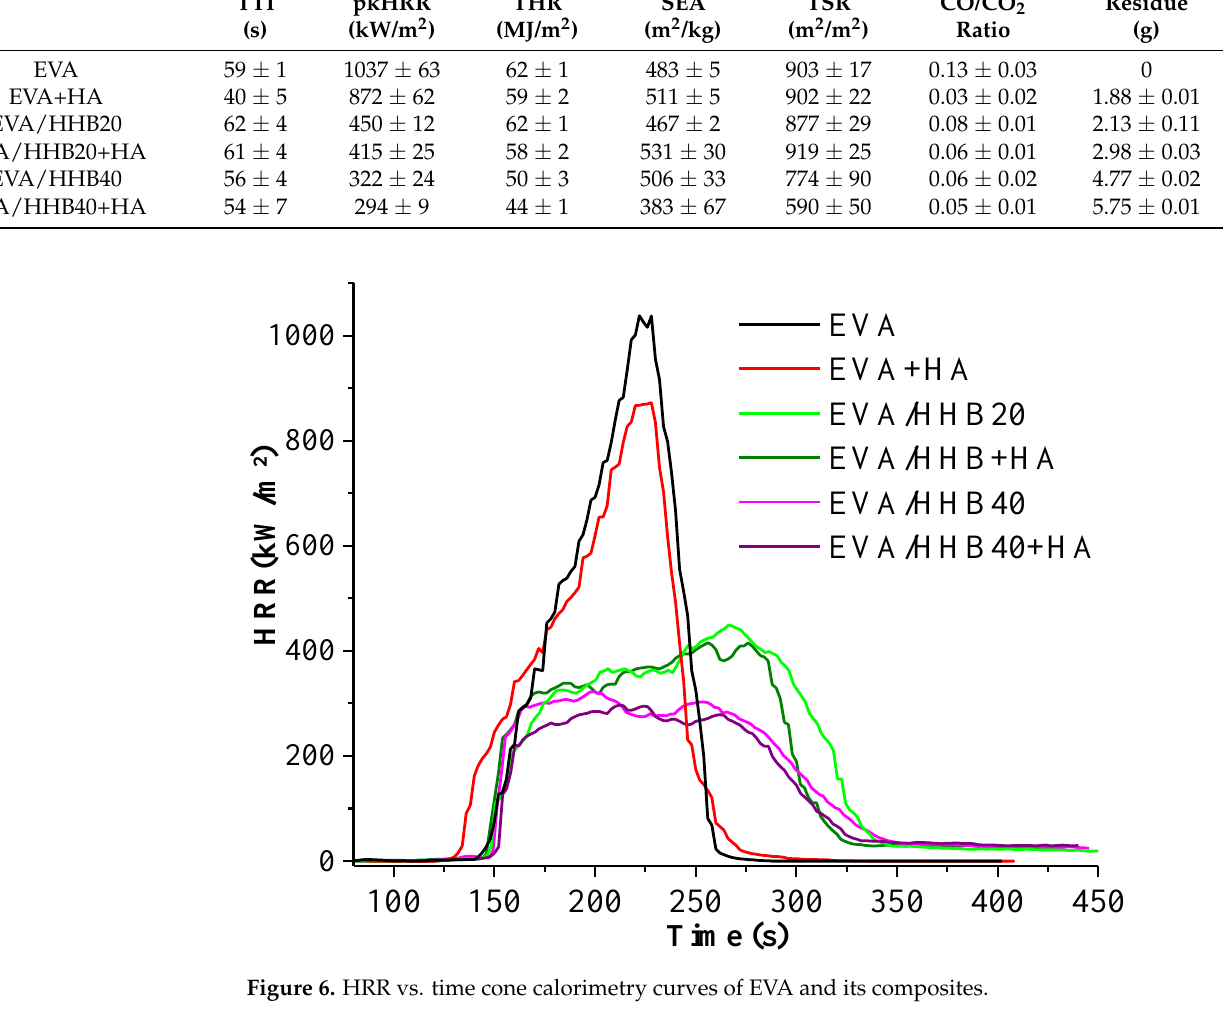
Figure 6. HRR vs. time cone calorimetry curves of EVA and its composites.